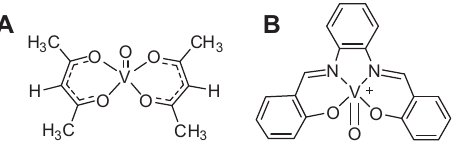
, 1.5 equiv. TBHP, 25 ° C]. 2